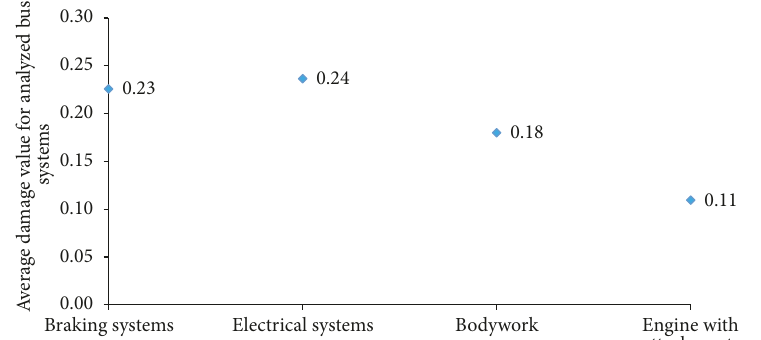
Figure 6: Average damage value for analyzed city bus systems.